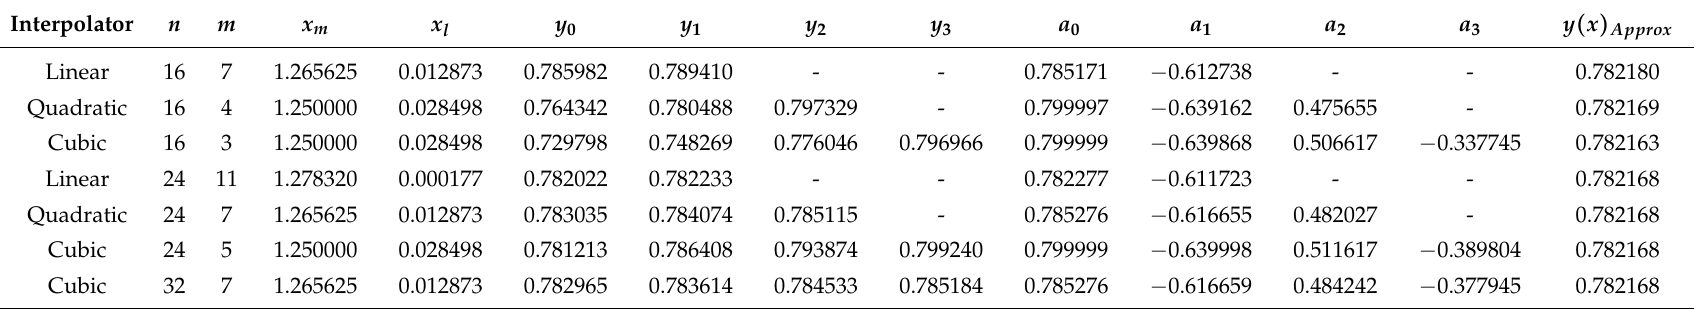
Table 1. Example approximation calculation, x = 1.278498, y ( x ) = 1/ x .